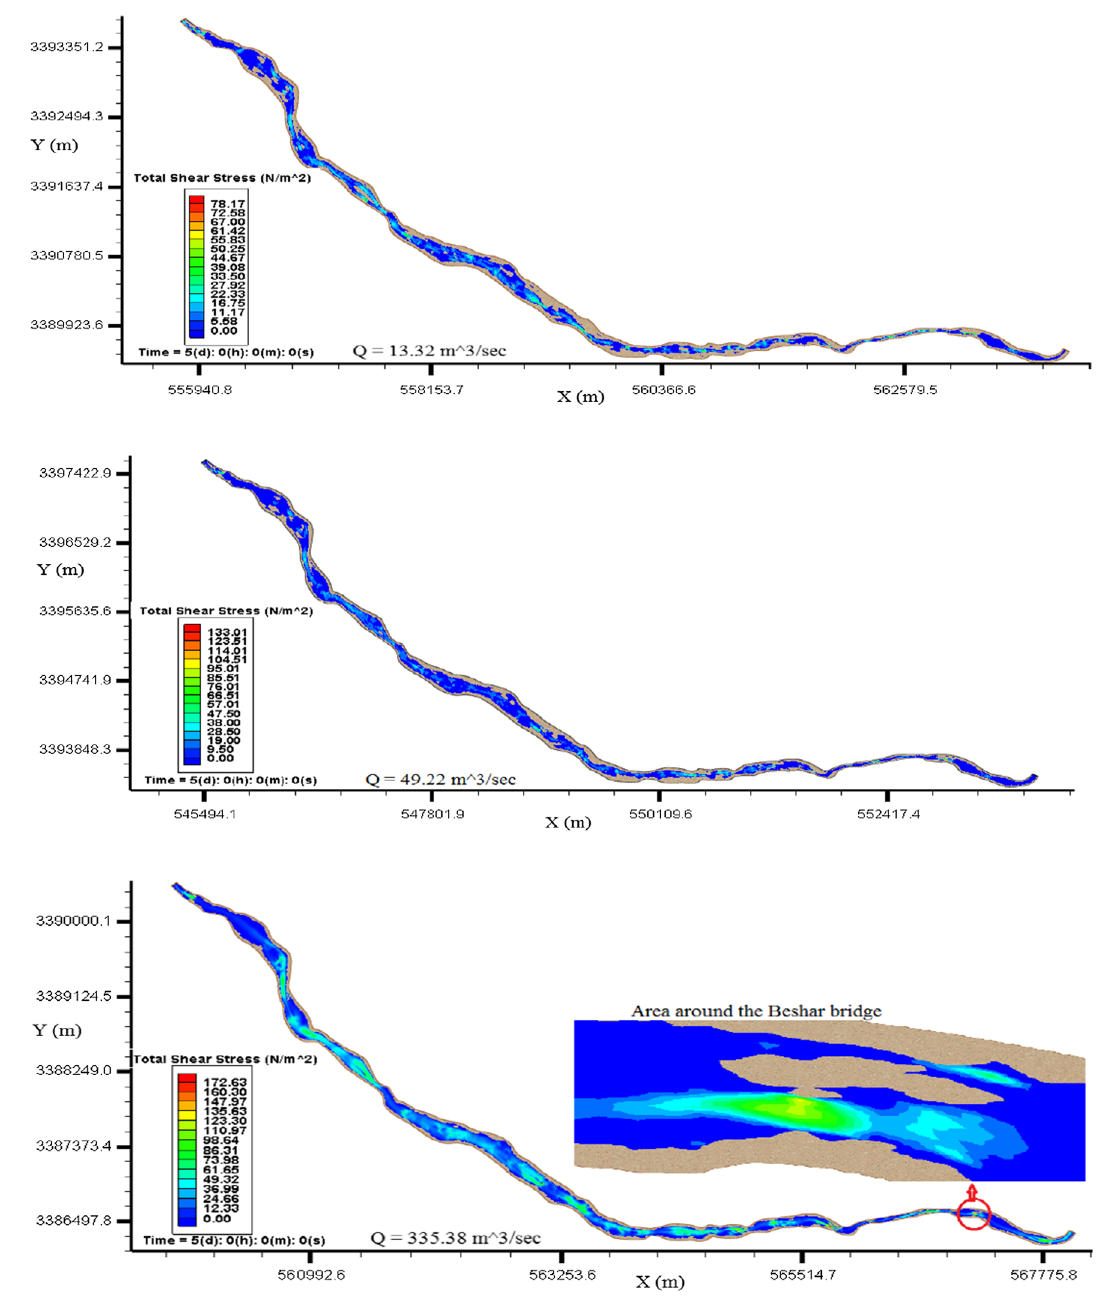
Fig. 13 Distribution of shear stress in the studied reach Table 4 Hydraulic parameters over the entire study